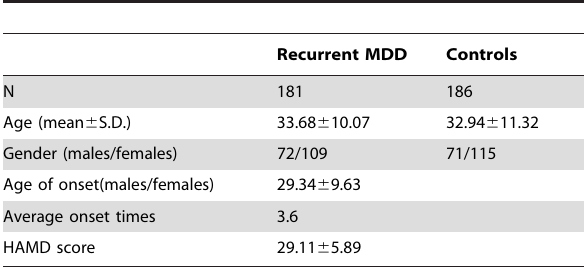
Table 4. Population characteristics of recurrent MDD patients and